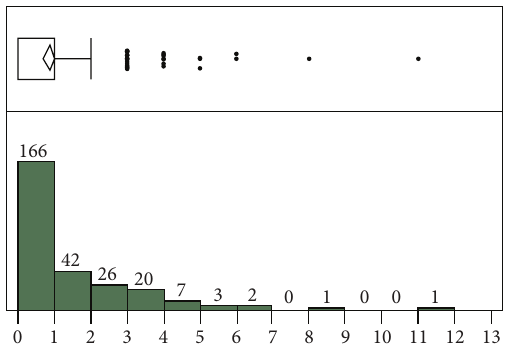
Figure 3: Derivation cohort: sum of the absolute value of the difference between the automatic and manual SOFA component scores. For the outlier box plot, the first box (red bracket) represents the first quartile, followed by the second and third quartiles. Fourth quartile outliers are represented by black dots. The triangle represents the mean difference (1.64).